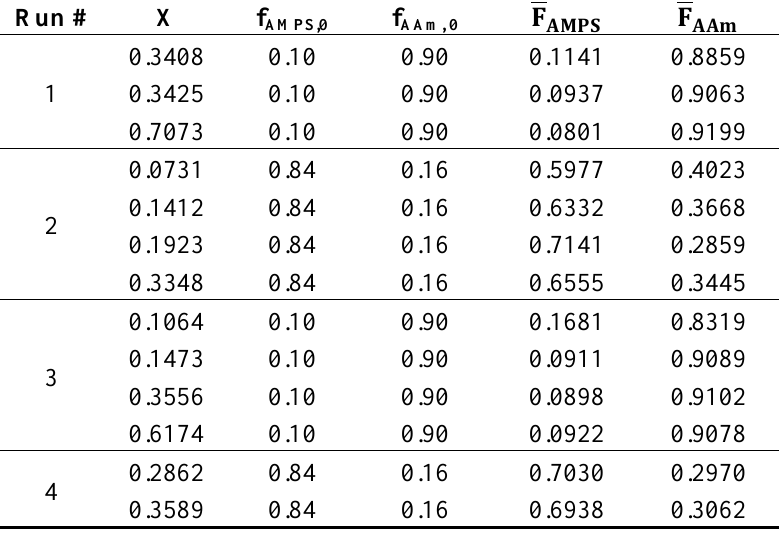
Table A2. Experimental data for AMPS/AAm copolymerization; Error-in-Variables-Model